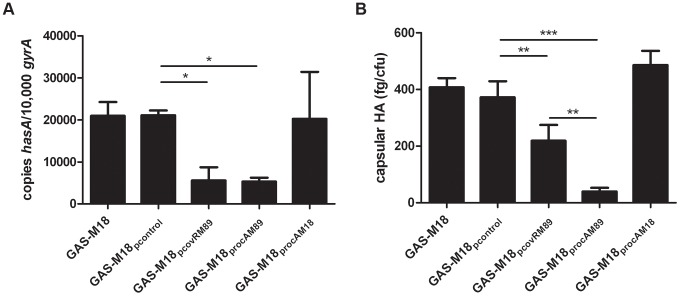
Over-expression of RocAM89 but not CovRM89 is sufficient to reverse serotype M18 hyper-encapsulation.Analysis of GAS-M18 strains over-expressing rocA
M89, rocA
M18 and covR
M89. (A) Absolute copy number of hasA transcripts quantified relative to housekeeping gene gyrA. Data shown from mid-logarithmic (ML) growth phase. (B) Capsular HA production was quantified at ML by ELISA. Data represent mean and standard deviation of three independent experiments measured in triplicate (ANOVA with Bonferroni pairwise comparison;* = p<0.05, ** = p<0.01, *** = p<0.001).